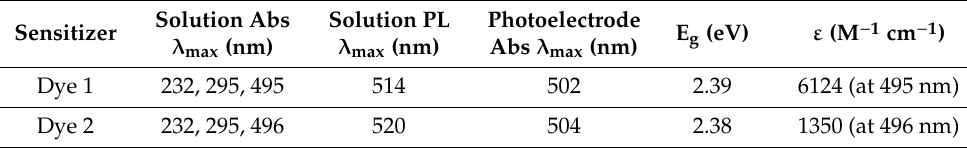
Figure 1. UV / Vis absorption (solid line) and photoluminescence (PL) emission (dotted lines) spectra of bodipy ( a ) dye 1 and ( b ) dye 2 solutions. (Excitation wavelength for PL emission was 400 nm) UV / Vis absorption spectra of TiO 2 sensitized photoelectrodes of bodipy ( c ) dye 1 and ( d ) dye 2, respectively. Black lines represent untreated TiO 2 photoelectrodes where green (dye 1) and red (dye 2) lines correspond to TiO 2 sensitized photoelectrodes. Table 1. Summary of spectral properties of bodipy dye 1 and 2 in ethanol solution (0.5 mM) and on photoelectrodes. The band gap values (E g ) were determined following the procedure reported elsewhere [37] and also from the Tauc plots (Supplementary Materials Figure S3) where the obtained values were comparable.